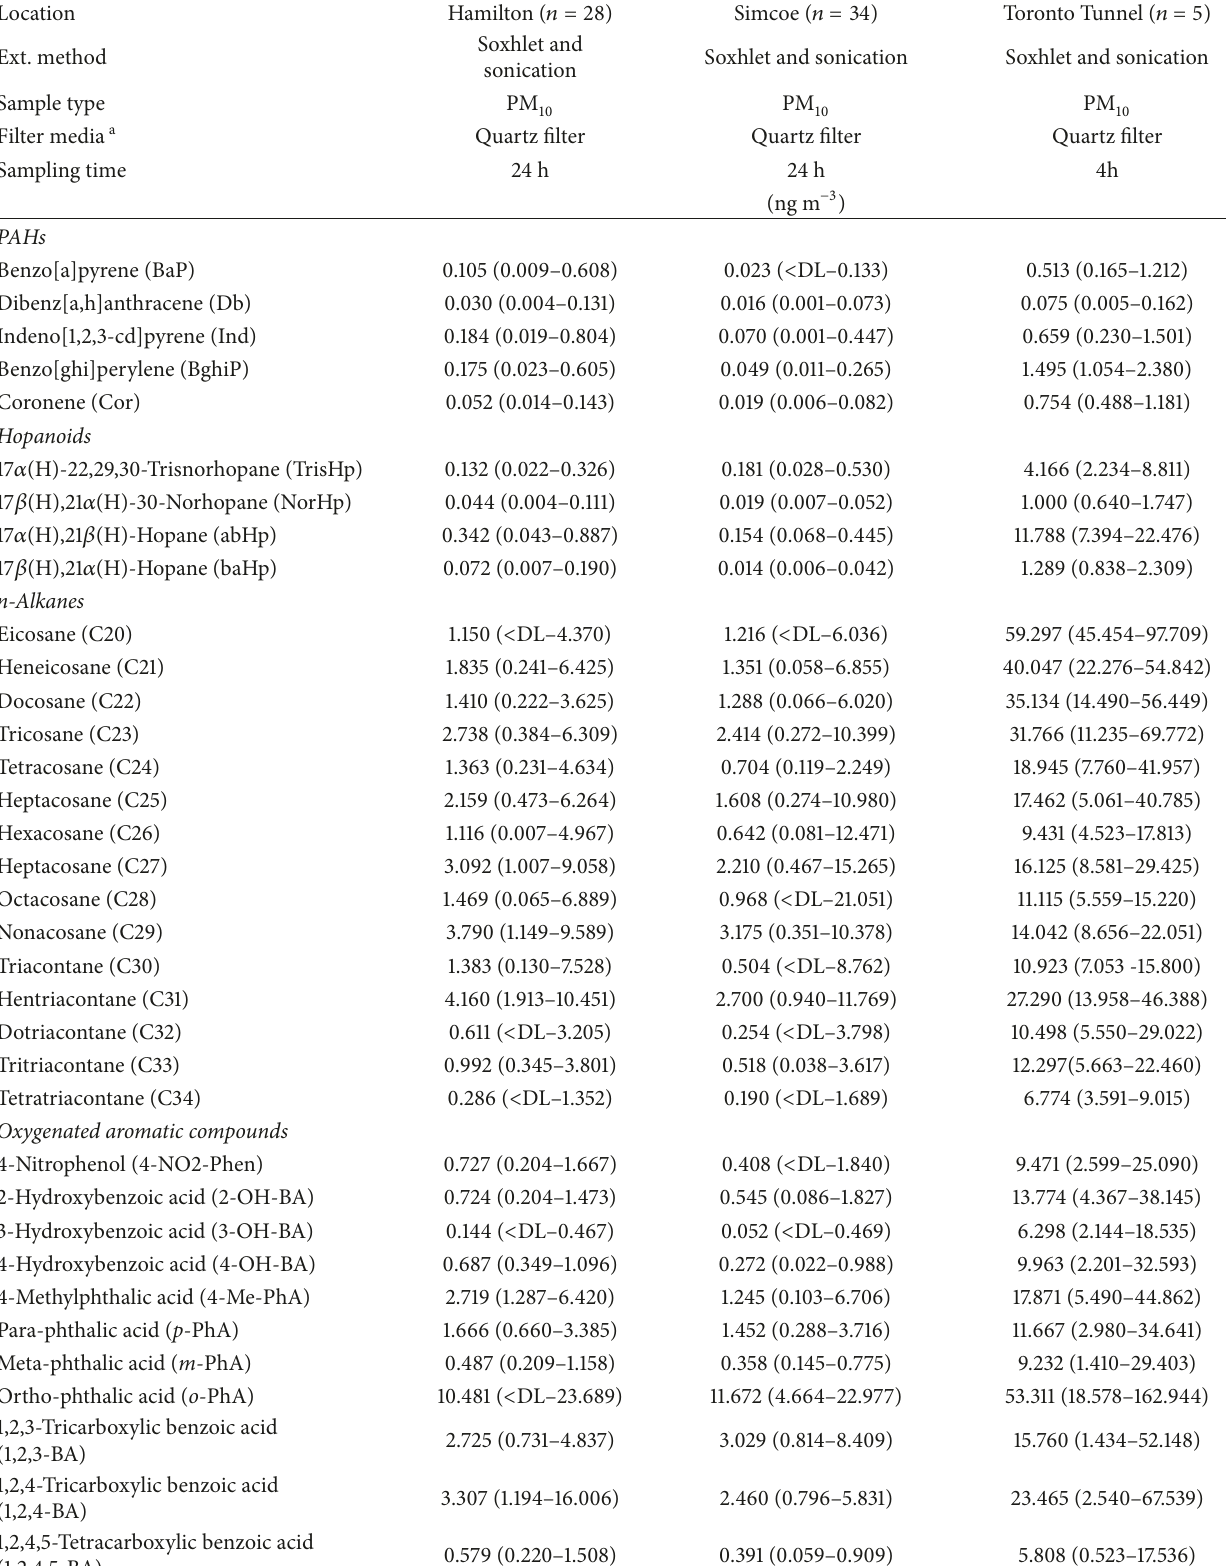
Table 1: Mean of molecular marker concentration and concentration range observed during the SONTAS